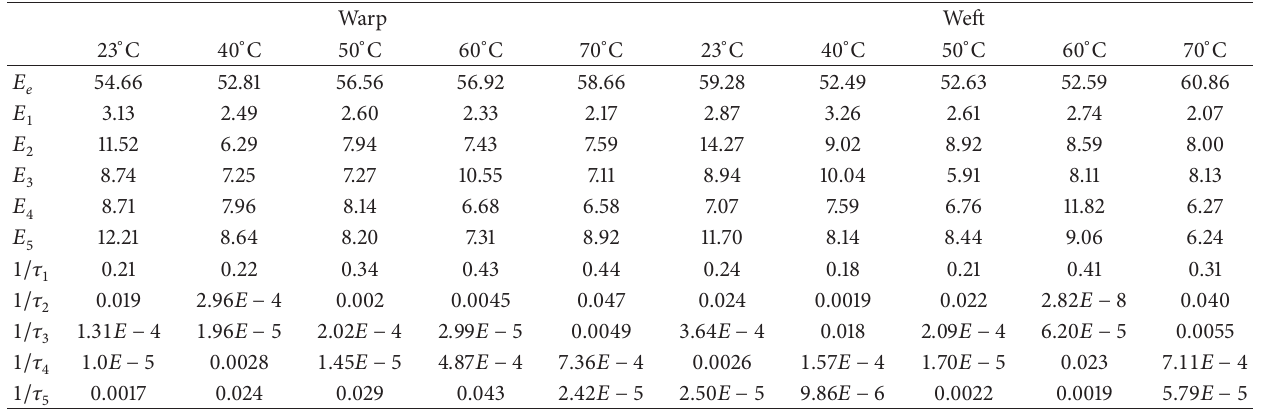
Table 2: Parameter results of the generalized Maxwell model (five-component